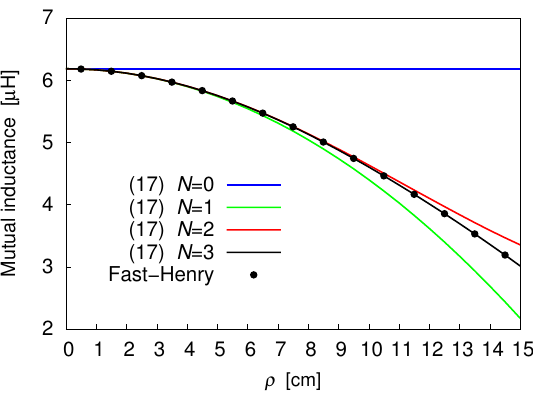
Figure 2. Mutual inductance of two 10-turn coils spaced 10 cm apart, as a function of ρ . Convergence of (17) is also confirmed by the ρ − profiles plotted in Figure 3. Here, the same coils as in the previous example are considered, while their planes are now separated by the distance h = 20 cm. As can be seen, even if the distance has been doubled, perfect matching is still observed between the outcomes of Fast-Henry solver and the trend arising from the proposed series-form solution truncated at N = 3. This suggests that the rate of convergence of (17) is not affected by a variation of h .